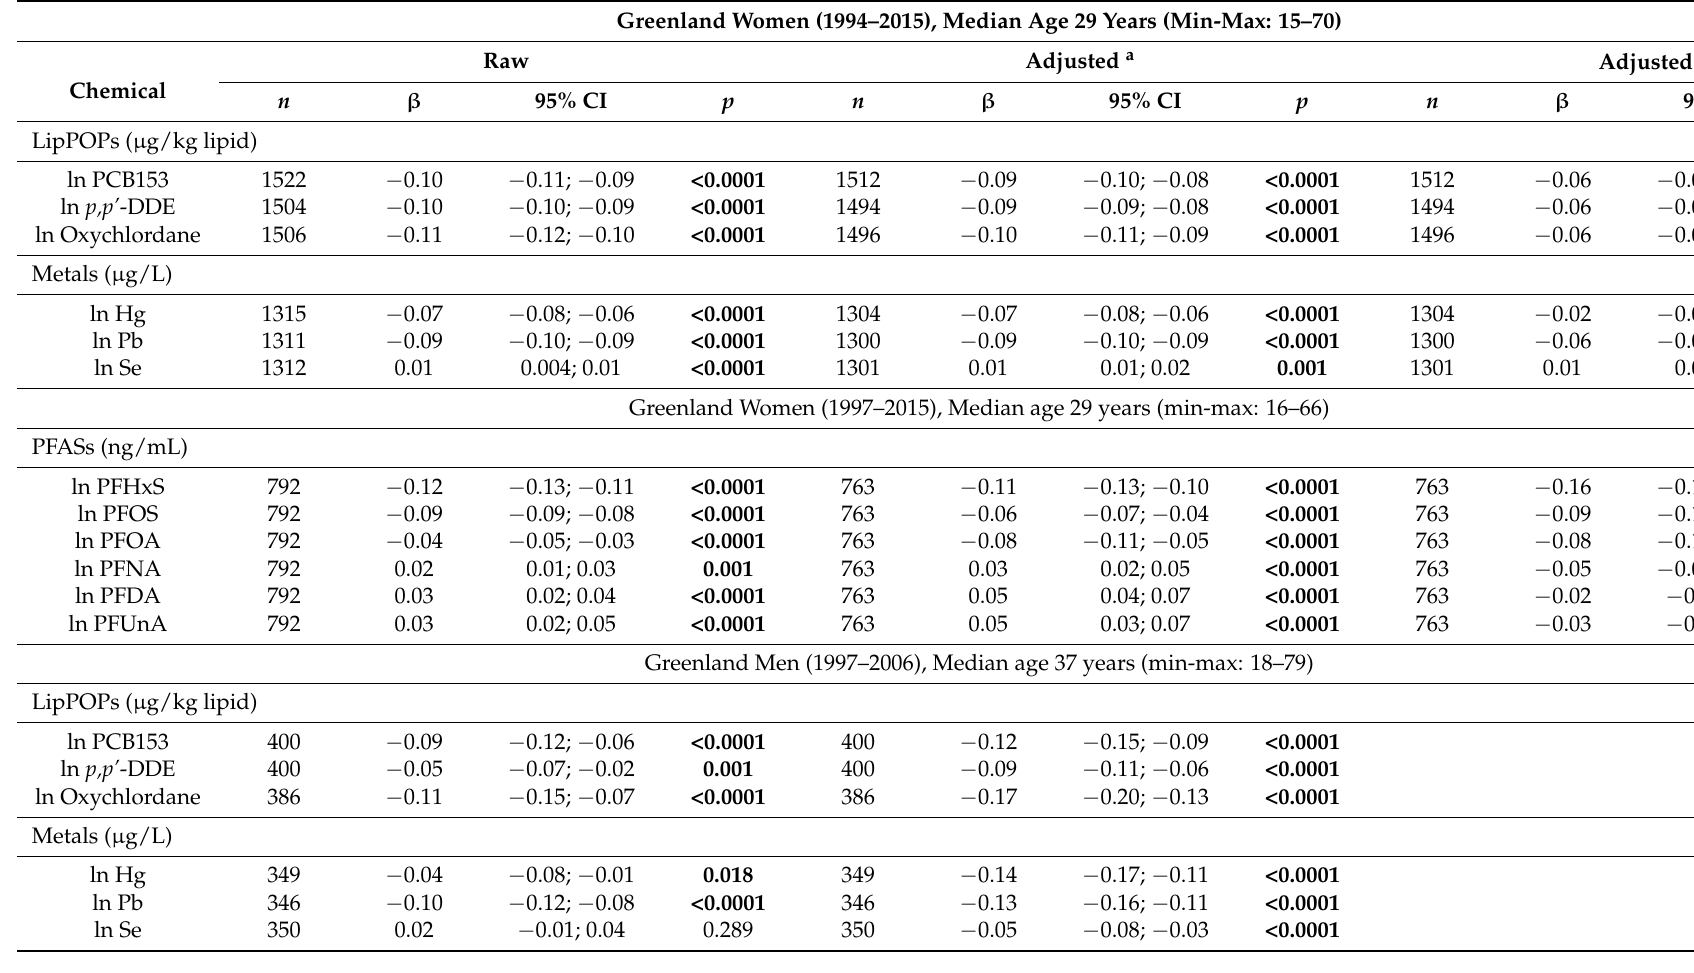
Table 5. Women and Men across Greenland : Time trend of lipPOPs, metals and PFASs